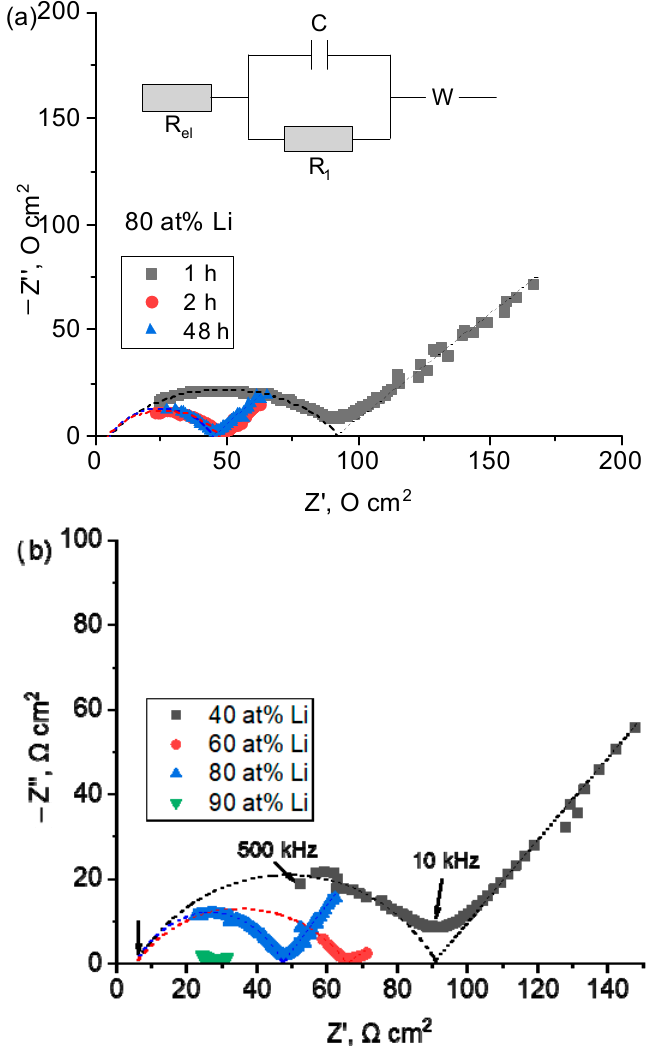
Figure 4. Impedance plots at 200 °C of Li-In | LLZcomp | Li-In cells after different heating times ( a ) and with different lithium contents in alloy ( b ).